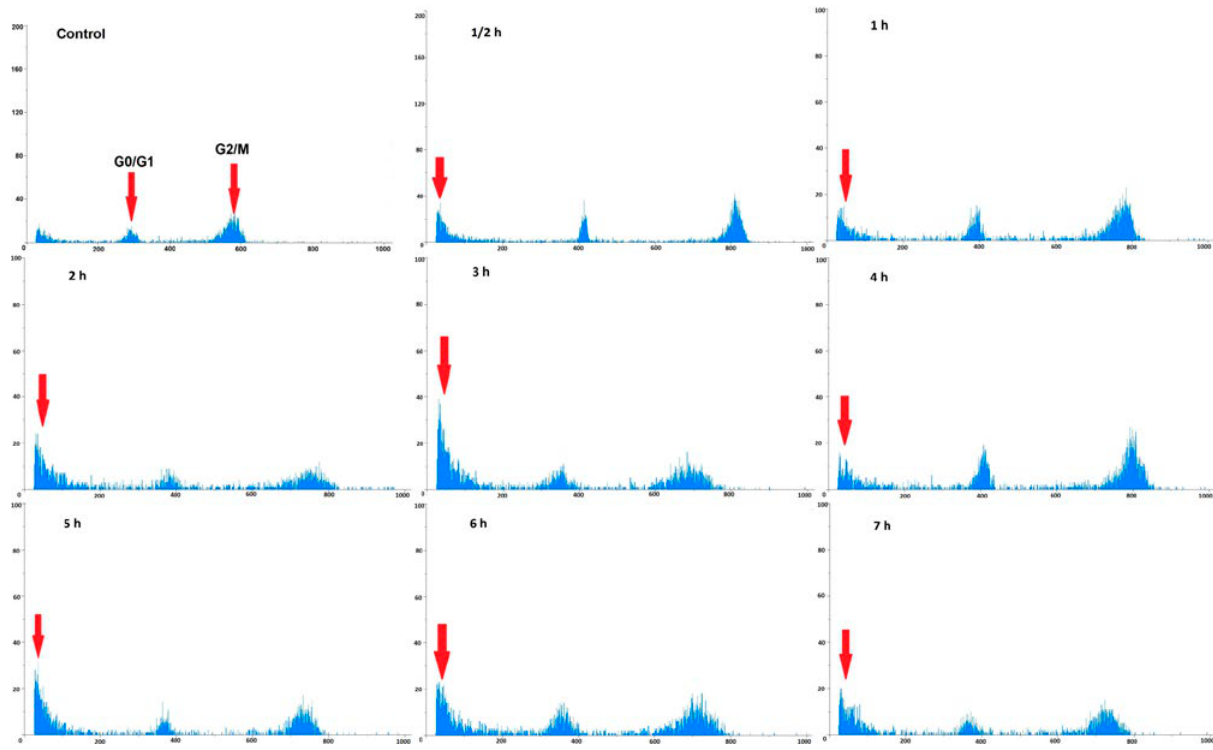
Figure 6. DNA fragmentation of control and 100 µM AlCl 3 treated barley roots at short term exposure. (x) axis denotes cell counts and (y) axis denotes fluorescence